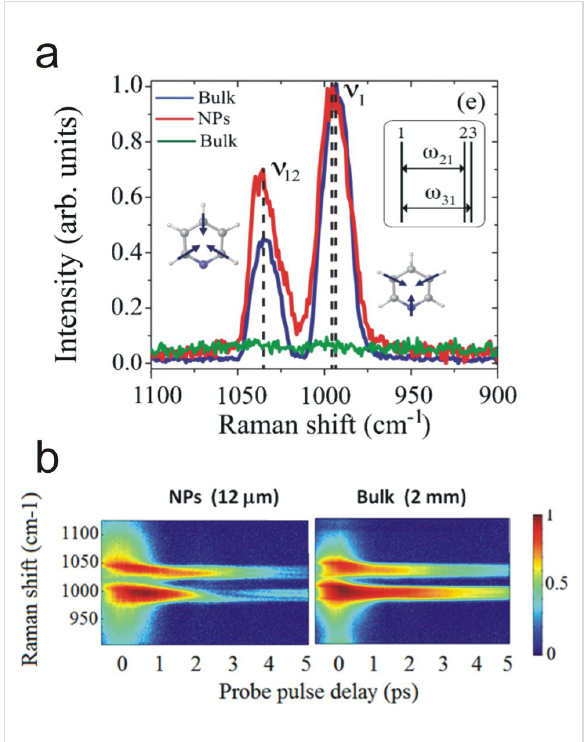
Figure 11: (a) SE-CARS spectrum obtained from a 12 µm thick layer of pyridine on the surface of NPs (red spectrum). The bulk CARS signal (without NPs) showed no detectable spectral features for a 12 µm thick sample (green), whereas a 2 mm thick layer gave the blue spectrum. Three vibrational modes were resolved: at 990 cm − 1 and 997 cm − 1 due to the ring breathing mode of free pyridine and hydrogen-bonded pyridine-water complexes, respectively; and at 1030 cm − 1 due to the triangle mode of a mixture of both species. (b) 2D (SE)-CARS spectrograms obtained by scanning the probe pulse delay. A delay of 1 ps led to a sharp improvement of the signal-to- background ratio, while narrow band probe pulse and adequate slit in the detection set-up led to a high spectral resolution. Figure adapted with permission from [90], Copyright 2012 Nature Publishing